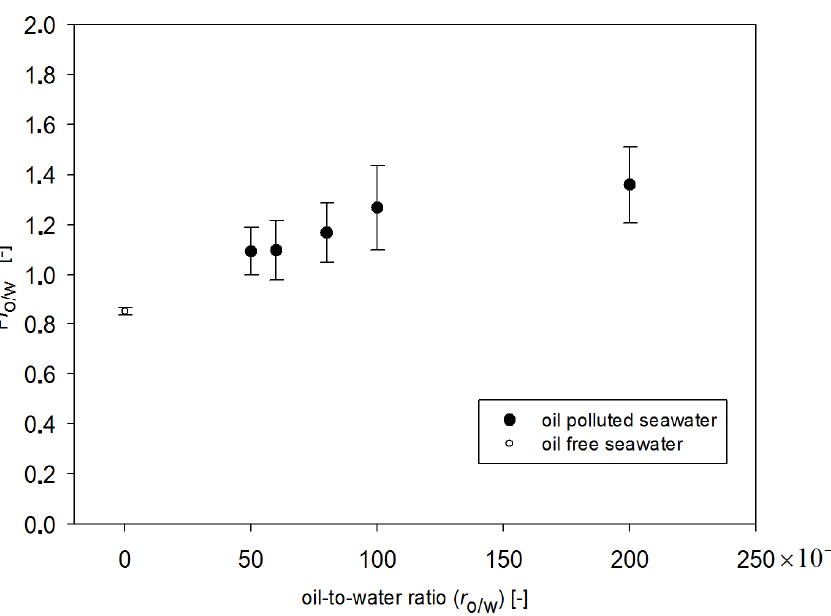
Figure 9. Fluorometric index FI with a standard deviation of the average for oil-free seawater and seawater artificially polluted by a mixture of oil.